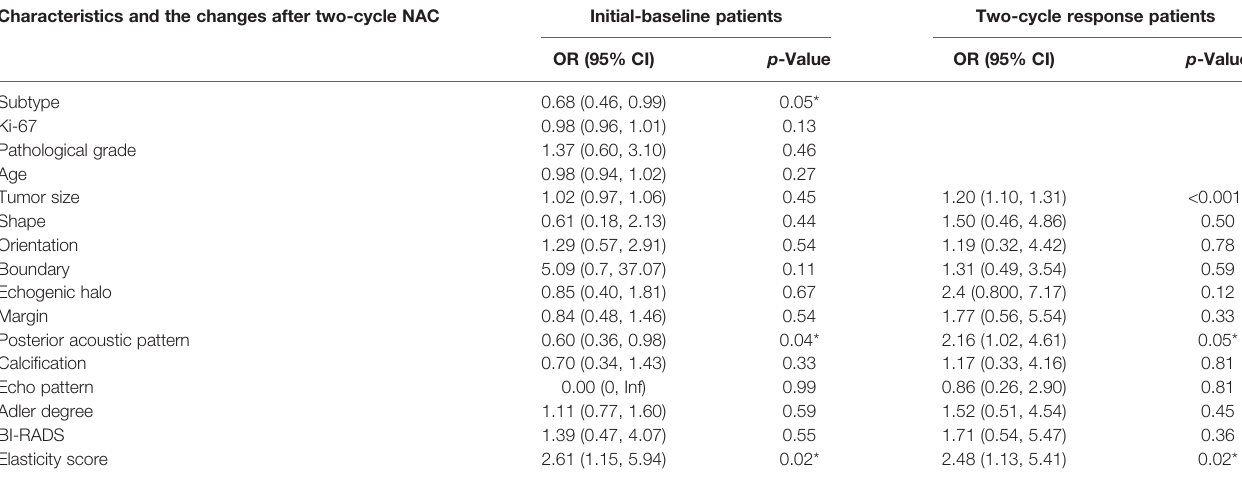
TABLE 2 | Multivariate logistic analysis of pCR in initial-baseline and two-cycle response patients based on the training cohort. Characteristics and the changes after two-cycle NAC